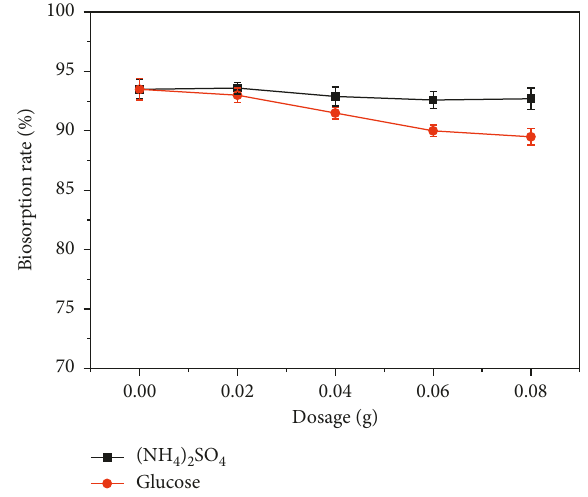
Figure 5: Effect of (NH